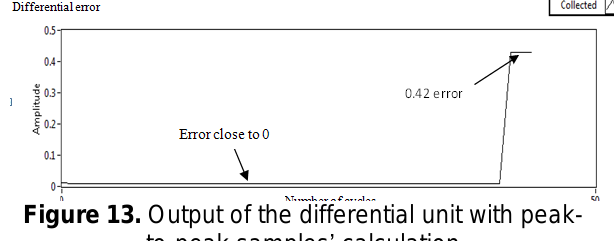
Figure 13. Output of the differential unit with peak- to-peak samples ’ calculation